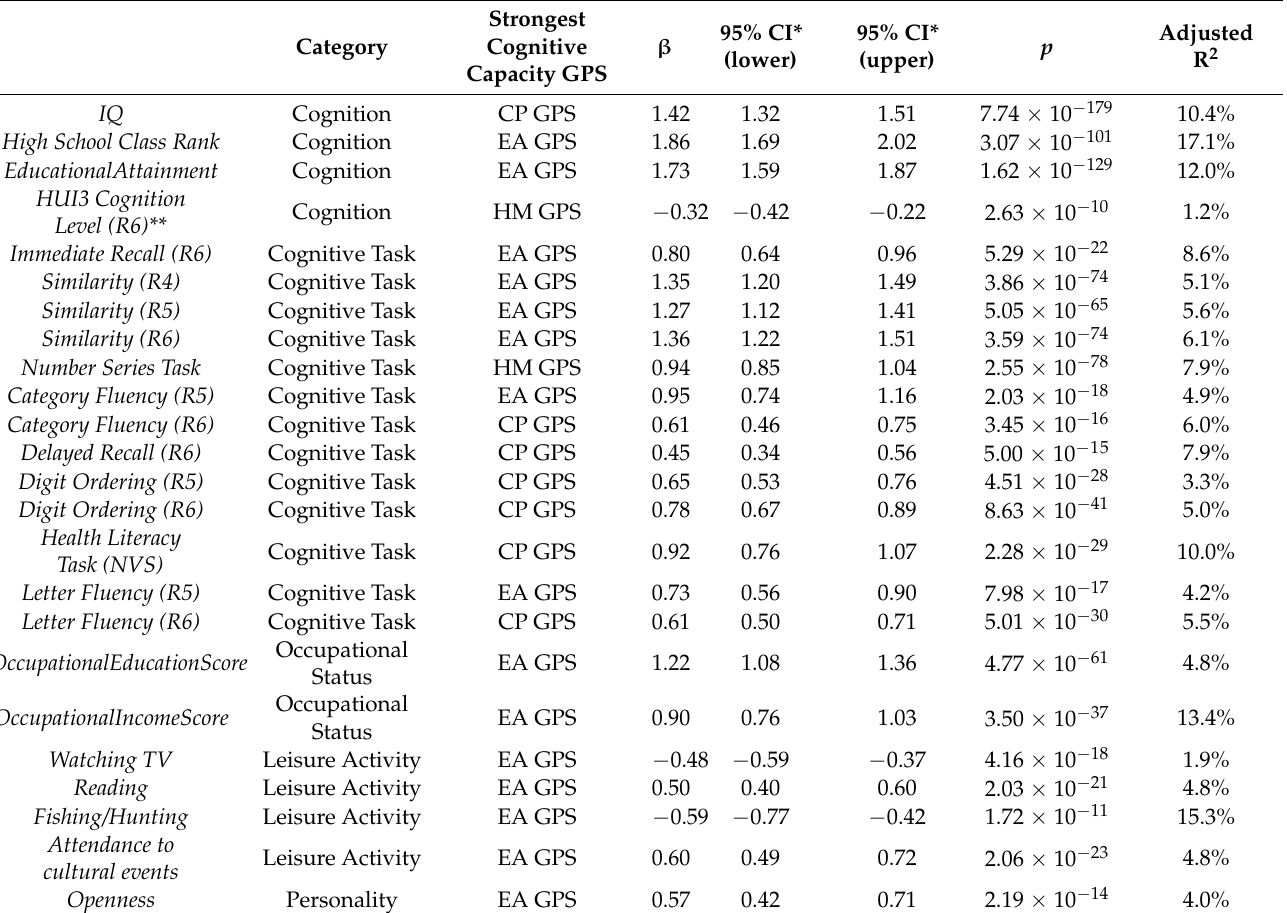
Table 1. Phenome-wide association studies (PheWAS) analysis for the four cognitive capacity GPSs with the cognitive/behavioral phenotypes. The table presents only the phenotypes significantly associated with all four cognitive capacity GPSs ( Educational attainment (EA), Cognitive Performance (CP), Math Ability (MA), and Highest Math Class (HM)). The top cognitive capacity GPS-phenotype associations are presented from the full PheWAS results (available in Supplementary Table S1). Positive β (effect size) indicates that the genetic contribution to cognitive capacities is positively correlated with a higher score for each measurement module. The significance level of p < 2.60 × 10 − 4 was used according to the Bonferroni